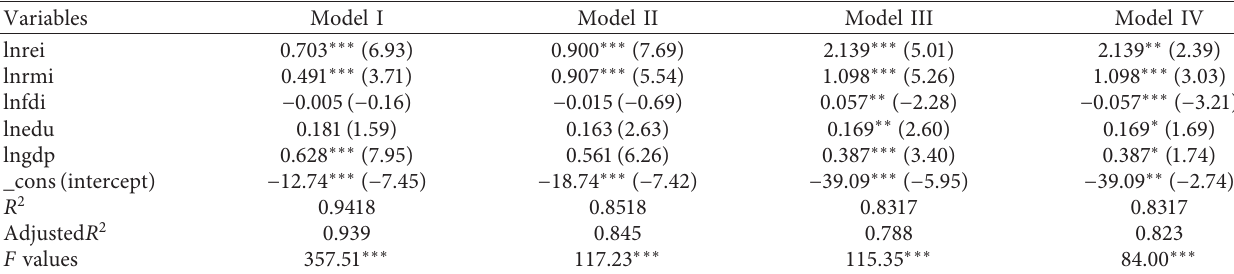
Table 4: The regression results of R&D input and scientific journal